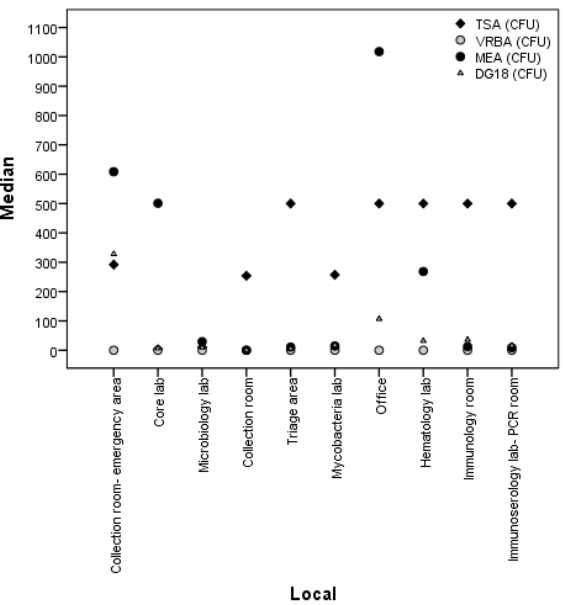
Figure 3. Comparison of fungal and bacterial load between collection sites in swabs.